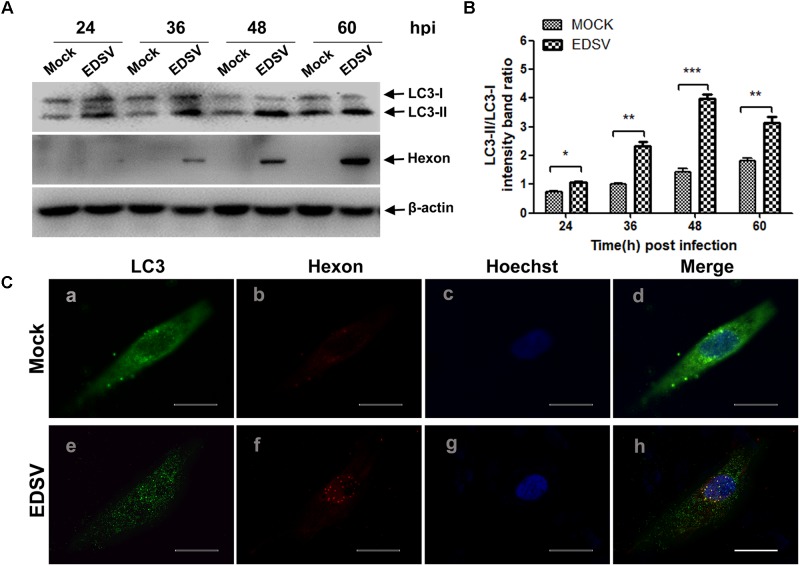
Modification of LC3 proteins during EDSV infection. (A) The significant conversion of LC3-l to LC3-ll was detected in mock-or EDSV-infected DEFs using an anti-LC3B antibody, and the expression of hexon from EDSV was also detected using anti-hexon antibodies. (B) The optical densities of each protein band were measured by densitometric scanning, and the optical density ratio of LC3-ll/LC3-l was calculated. The results are shown as the mean ± SEM (n = 3). ∗P < 0.05; ∗∗P < 0.01; ∗∗∗P < 0.001. (C) Confocal immunofluorescence microscopy images of mock-infected control and EDSV-infected DEFs. Mock- and EDSV-infected cells were fixed at 36 hpi and stained with antibodies against LC3 and EDSV hexon and then merged. Scale bar: 10 μm. Cell nuclei were counterstained with Hoechst. Fluorescence images were examined under a confocal laser scanning microscope. Scale bar = 10 μm.